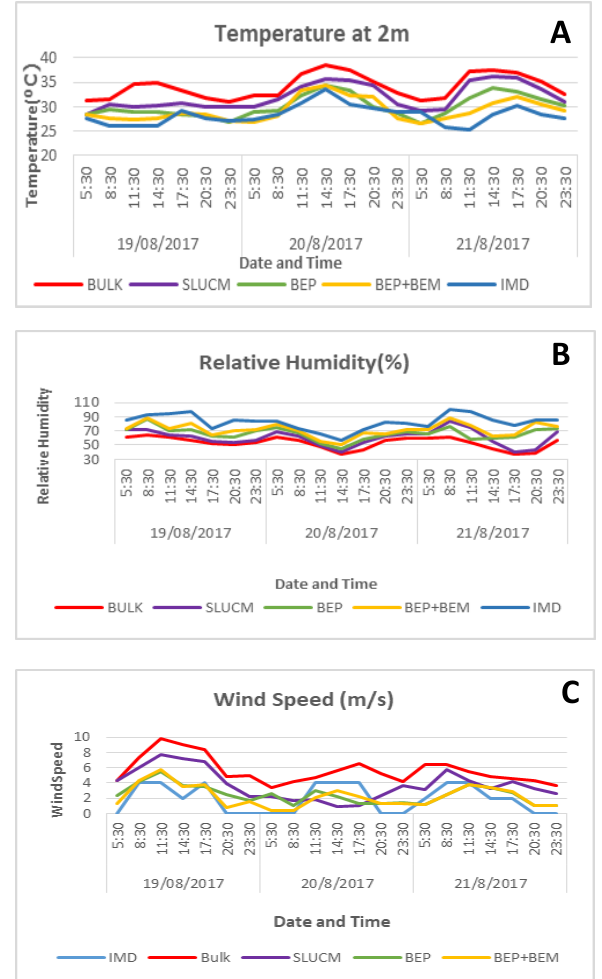
Figure 7. Comparison between observed and simulated A) Temperature B) Relative Humidity C) Wind Speed simulated A) Temperature B) Relative Humidity C) Wind